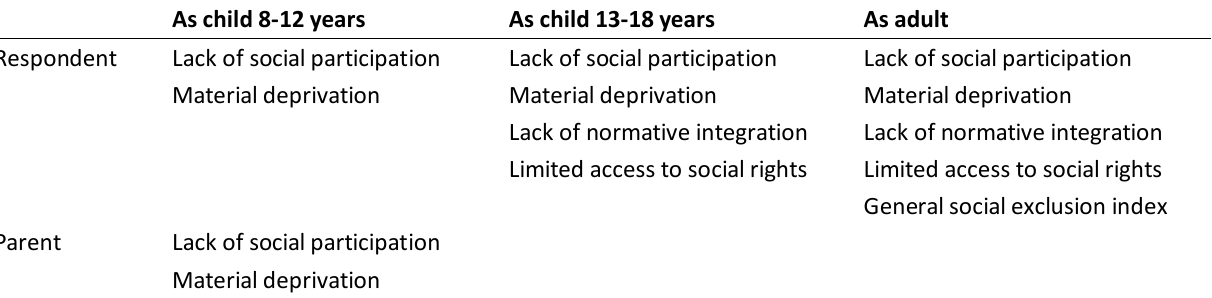
Table 6 . Social exclusion scales available in the scarring effects